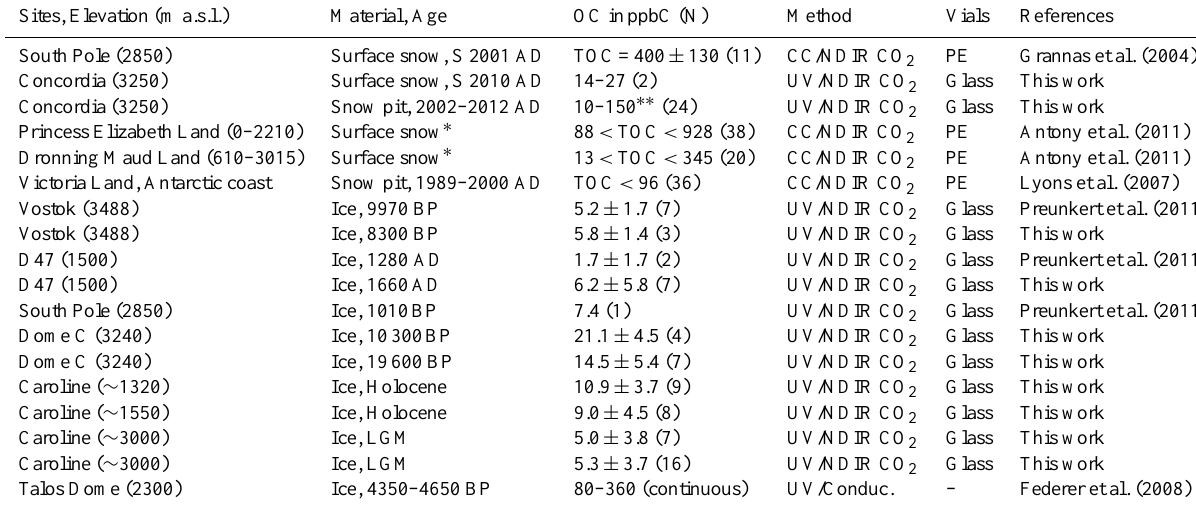
Table 1. Organic carbon content measured in snow and ice from various Antarctic sites. TOC refers to total organic carbon concentrations obtained with a catalytic combustion (CC) method. All other values that were obtained with a UV oxidation method without filtration of samples would correspond to dissolved organic carbon (DOC). However, as discussed in Sect. 3.2.1, a large part of the particulate organic fraction present at levels of a few ppbC (i.e., less than 10% of DOC) in Antarctic snow and ice would have been oxidized even when using a UV method. For the methods, NDIR CO 2 refers to a non-dispersive infrared CO 2 detector, and Conduc. to a CO 2 electrolytic conductivity detector. PE denotes the use of polyethylene vials. S refers to summer season. N is the number of analysed samples. Sites, Elevation (m a.s.l.)